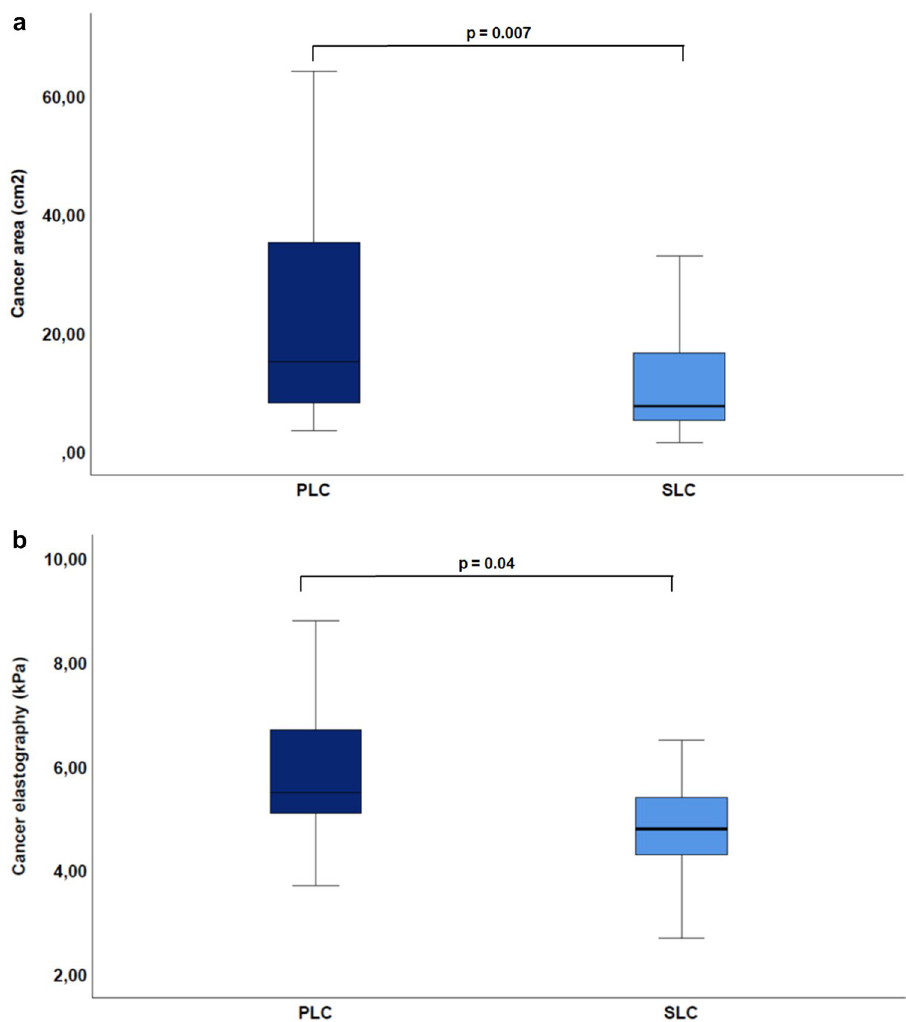
Figure 6. Comparison of PLC vs. SLC ( a ) area (cm 2 ) ( p = 0.007). ( b ) Cancer elastography ( p =